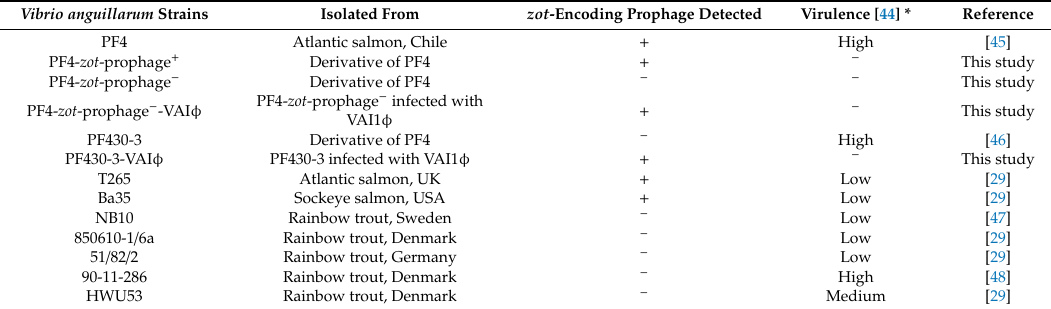
Table 1. Overview of the Vibrio anguillarum strains used in this study, their source of isolation and the detection of zot -encoding